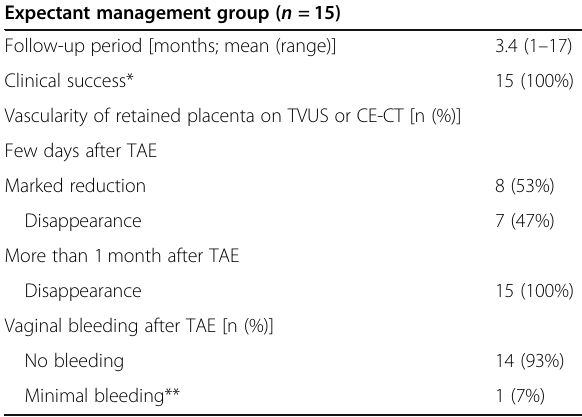
Table 3 Clinical outcomes of TAE without hysteroscopic resection